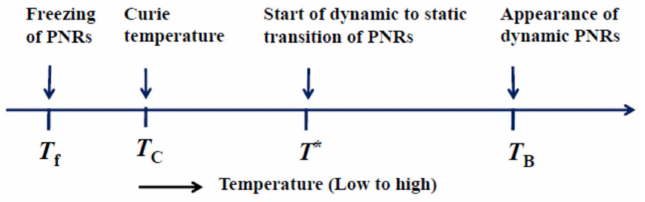
Figure 9. Characteristic temperatures of relaxor ferroelectrics. Polar nanoregions (PNRs) play a main